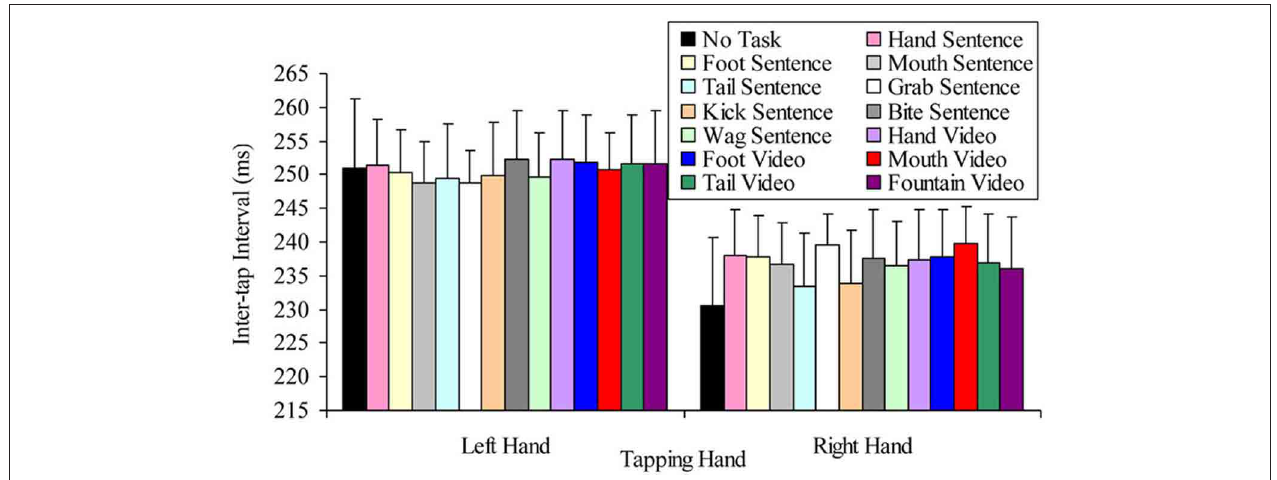
FIGURE 10 | Mean inter-tap intervals of each hand under the different concurrent semantic task conditions (error bars represent one standard error of the mean).